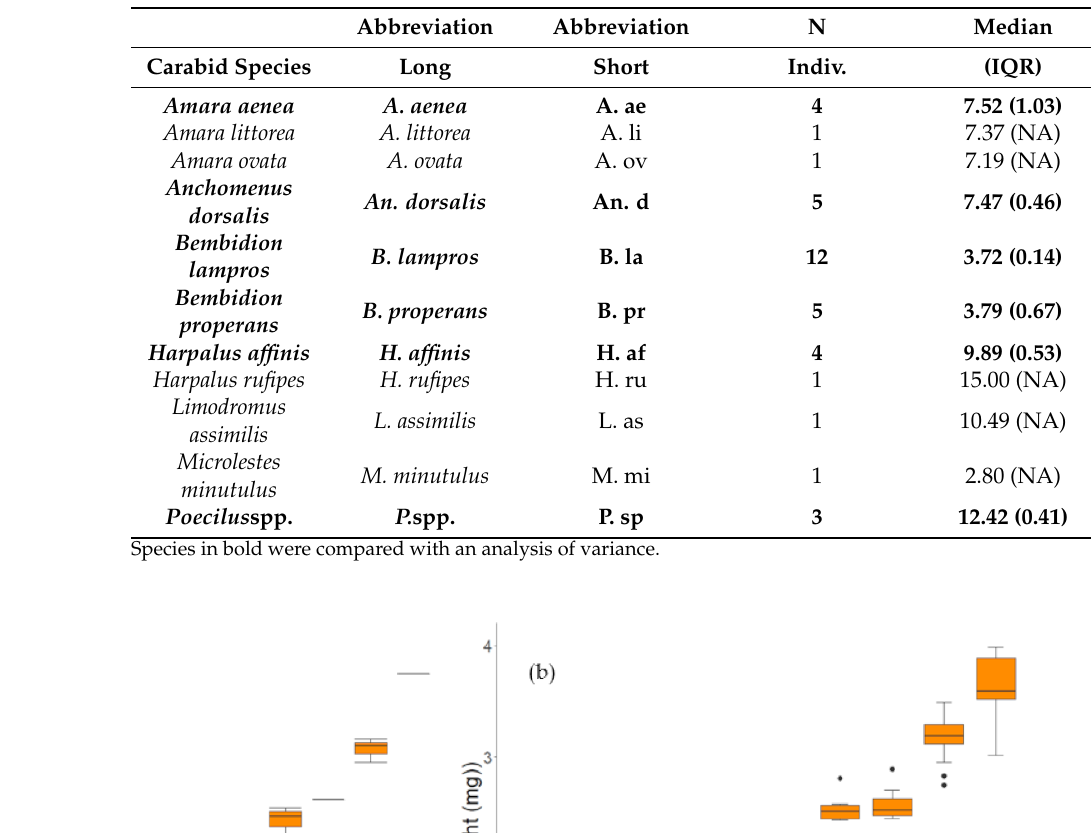
Table 1. List of carabid species, number of individuals (N Indiv.) per species, and measured body size in mm (median with interquartile range, IQR) of carabid beetles screened for fungal propagules by the culture-dependent method.